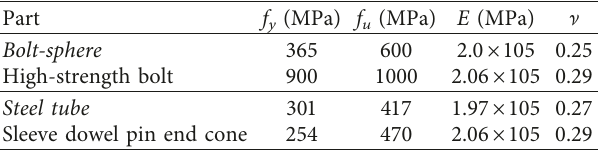
Figure 2: Details of a bolt-sphere joint. Table 1: Material properties of each